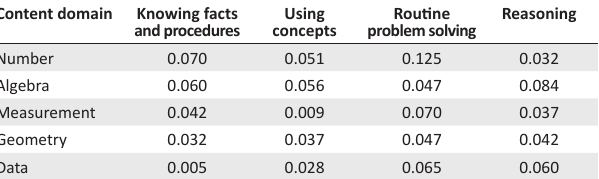
TABLE 7 : TIMSS 2003 Grade 8 Mathematics content and cognitive domain matrix for test